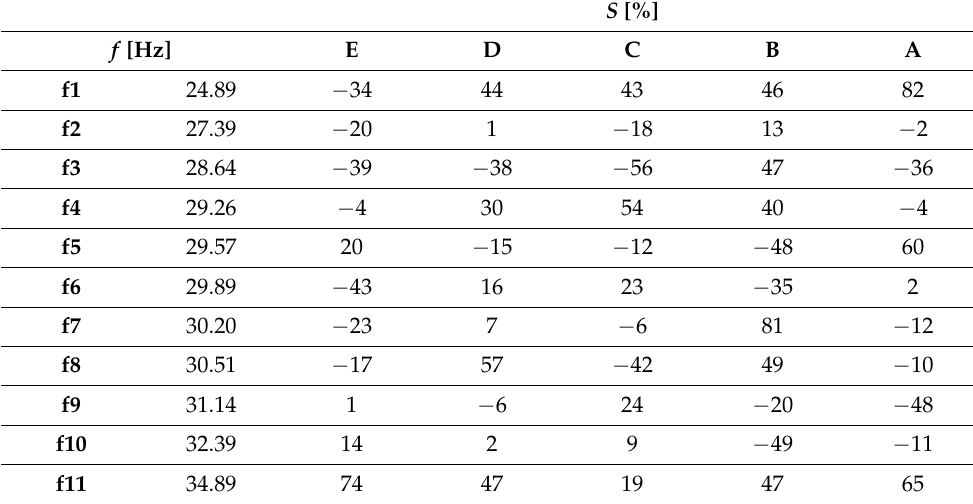
Figure 4. Dependence of the response rate parameter S of a biological system on the change in frequency. Table 1. The percentual rate of a biological system response to a frequency change.